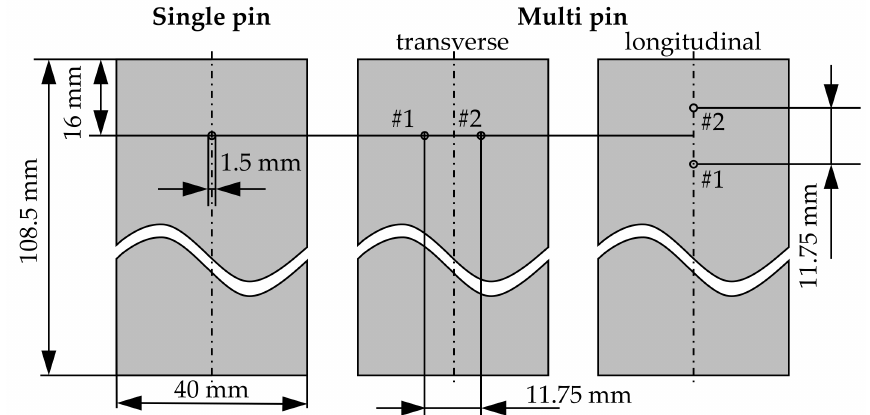
Figure 2. Schematic illustration of the investigated pin arrangements.